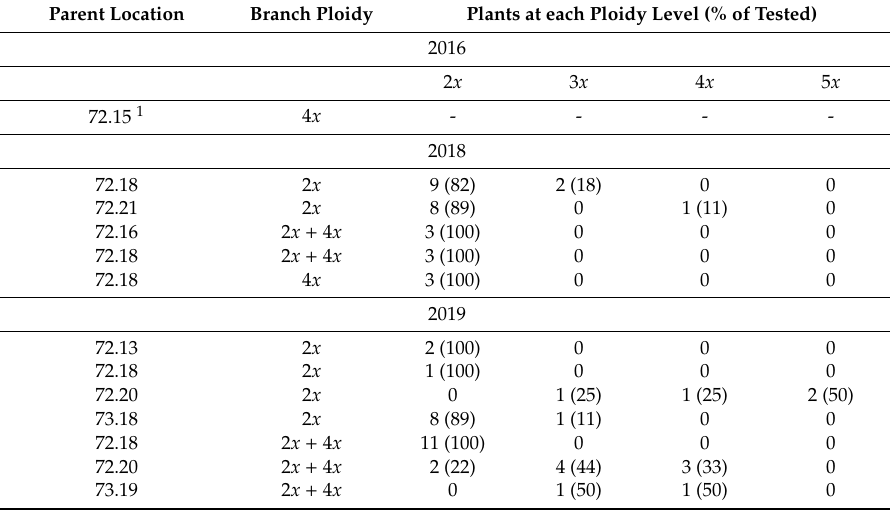
Table 8. Ploidy analysis using flow cytometry of seedlings resulting from open-pollination of field grown Acer buergerianum (trident maple). Seed were collected from 2016, 2018, and 2019 flowering season,